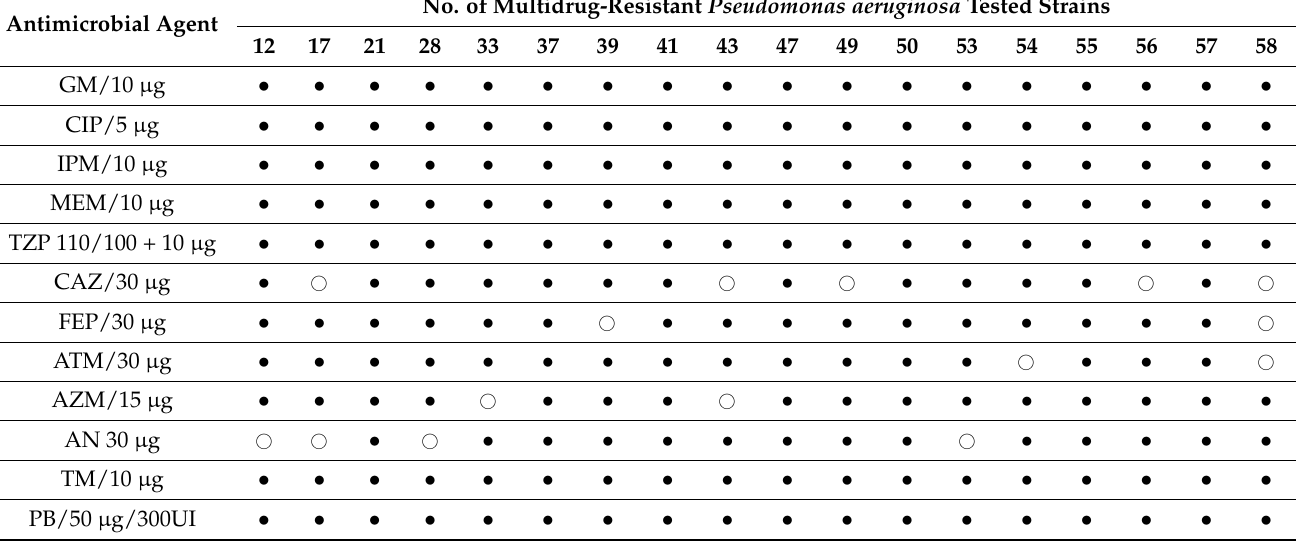
Table 3. Multidrug-resistant phenotype of Pseudomonas aeruginosa strains isolated from dogs with superficial infections: resistance (full circles) and susceptibility (empty